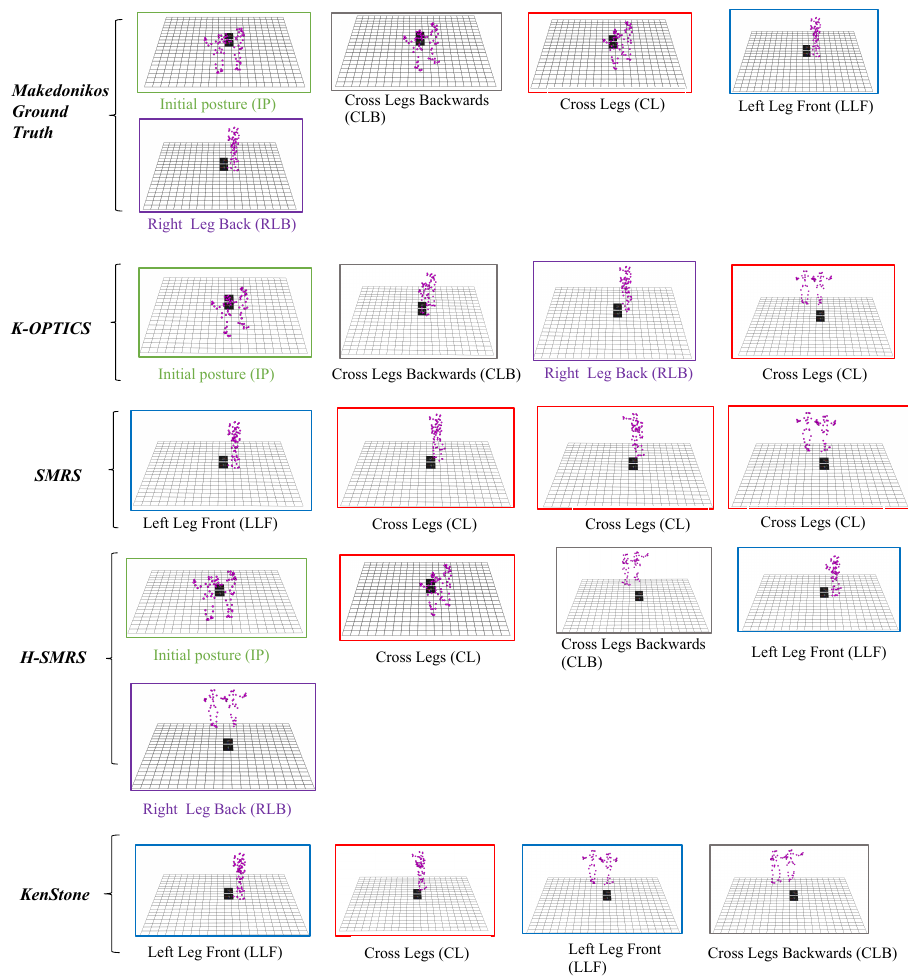
Figure 11. A visual representation of the key frames extracted by the four summarization algorithms than the ground truth ones in case of Makedonikos